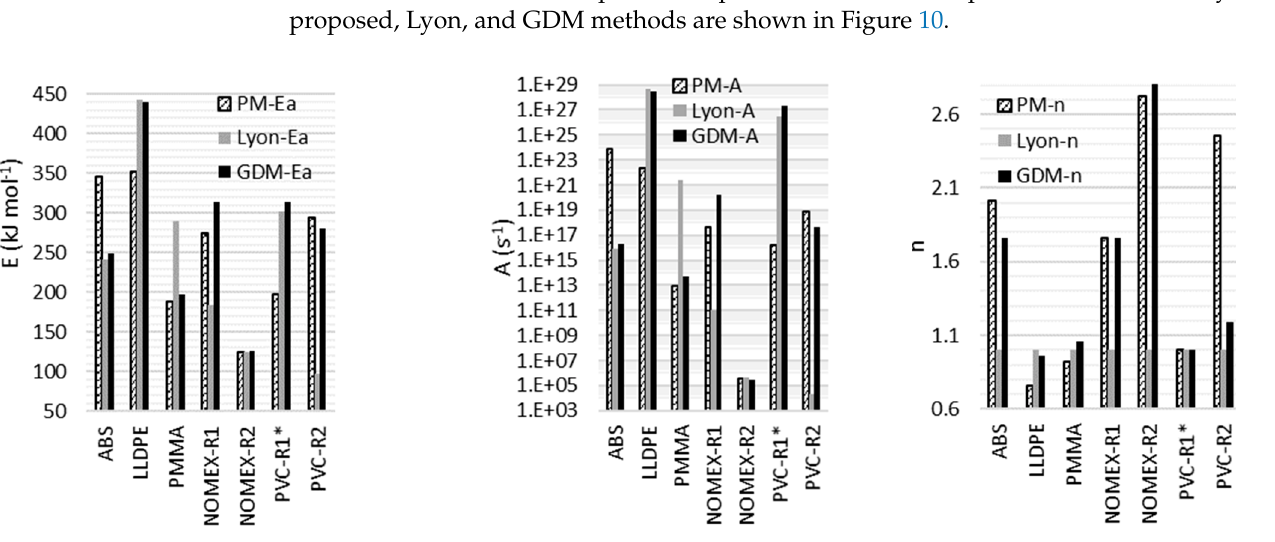
Table 6. Mean absolute error of mass- T and dm / dT-T responses versus experimental results for five polymer materials obtained by different methodologies. Curve